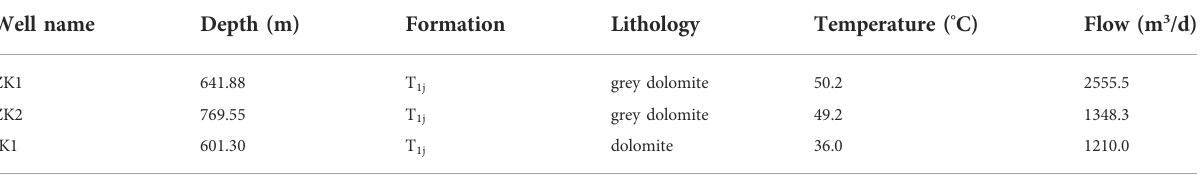
TABLE 1 Experimental sample information of Well ZK1, ZK2, and